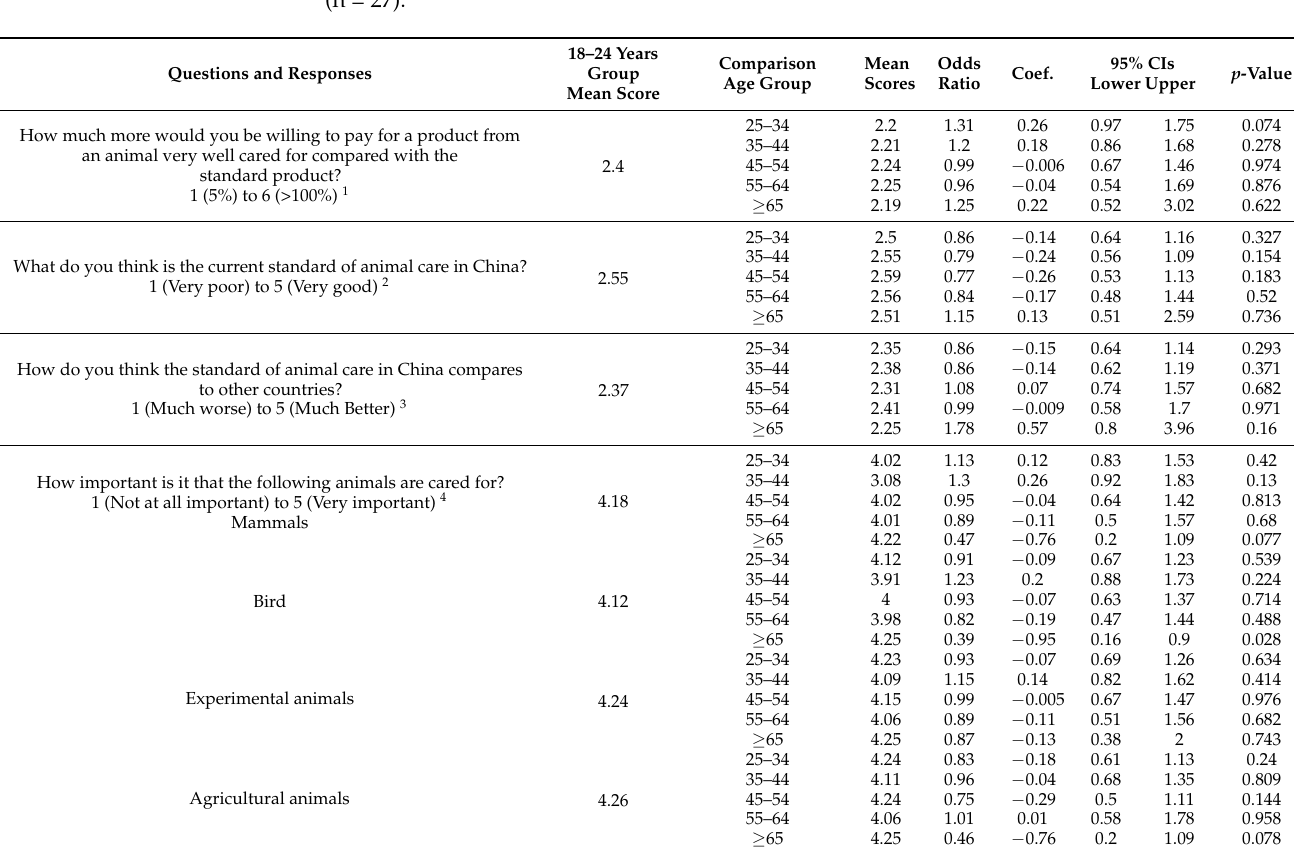
Table A2. Age effects on respondents’ perception of attitudes towards animal welfare in China.